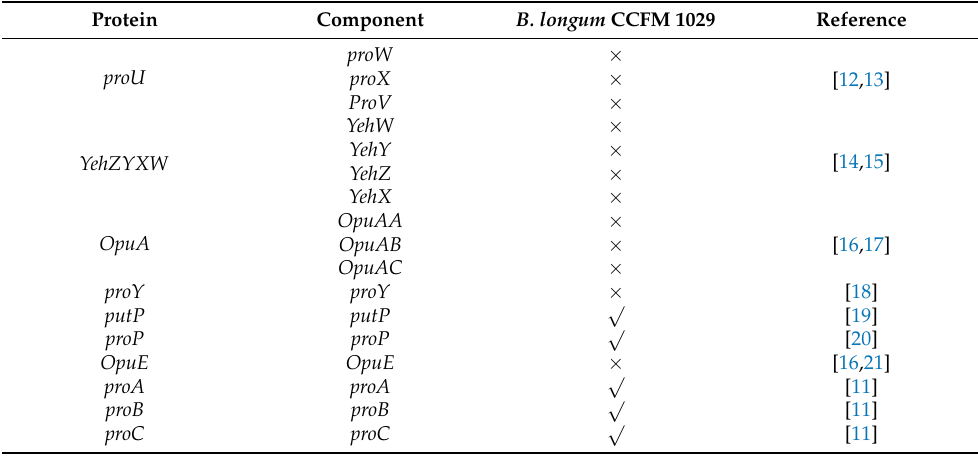
Table 1. The candidate genes related to proline transport and synthesis in B. longum CCFM 1029. Protein